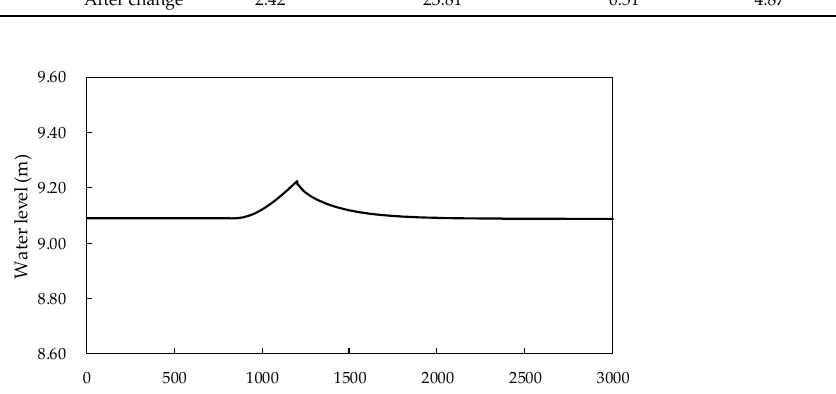
Figure 10. Variation of the water level immediately upstream of P2 when the upstream discharge was increased by 1.1 m 3 /s.